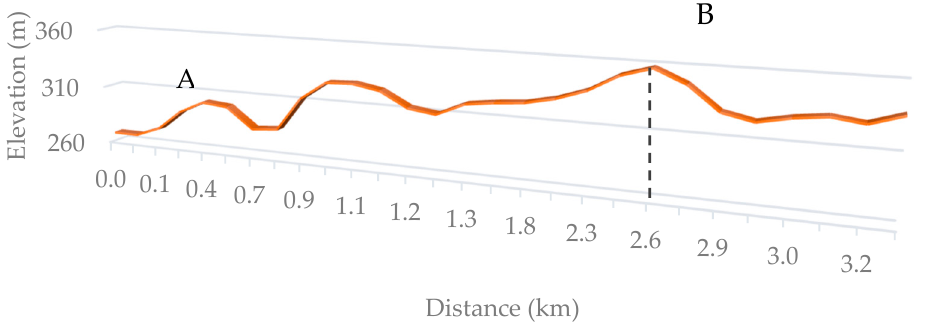
Figure 8. Potential pipeline path showing the topographical